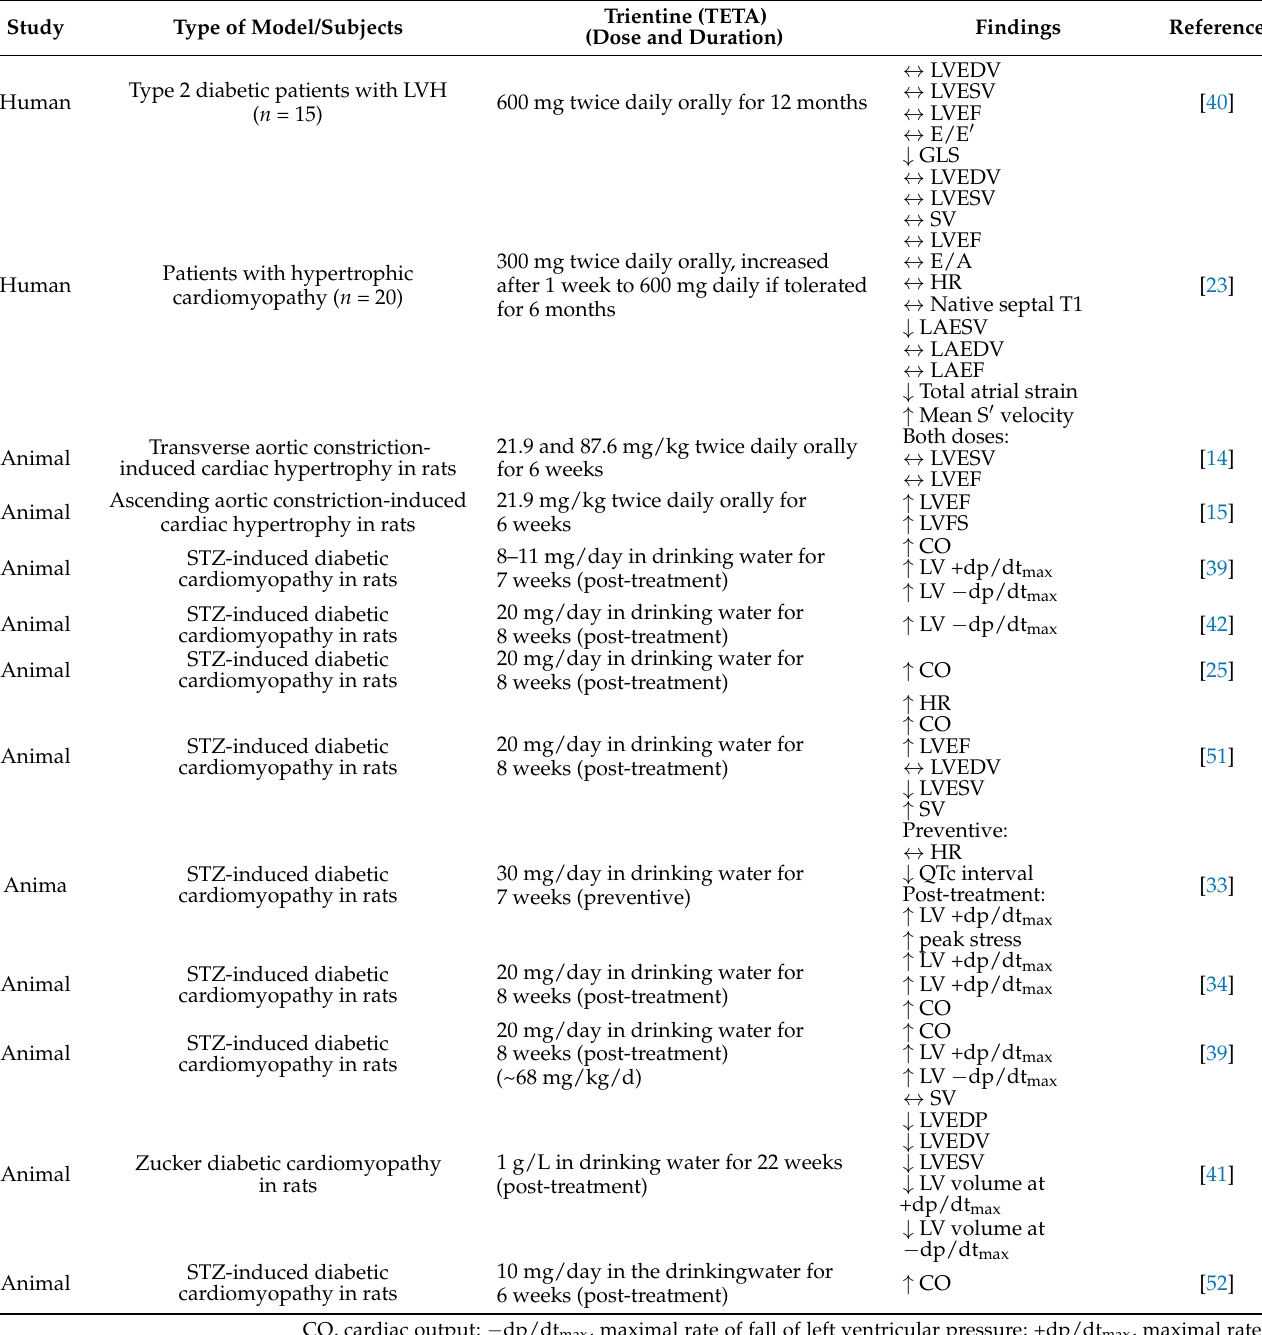
Table 3. Effects of trientine on cardiac function in human and animal